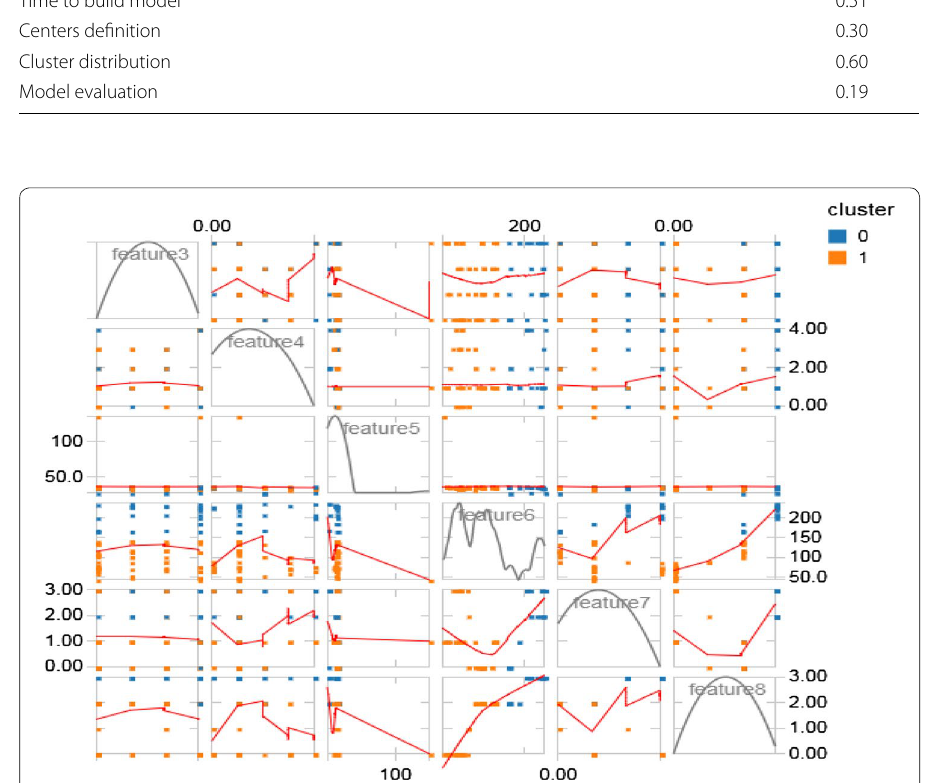
Fig. 12 Scatter plot of Kmeans clustering with relationship of features